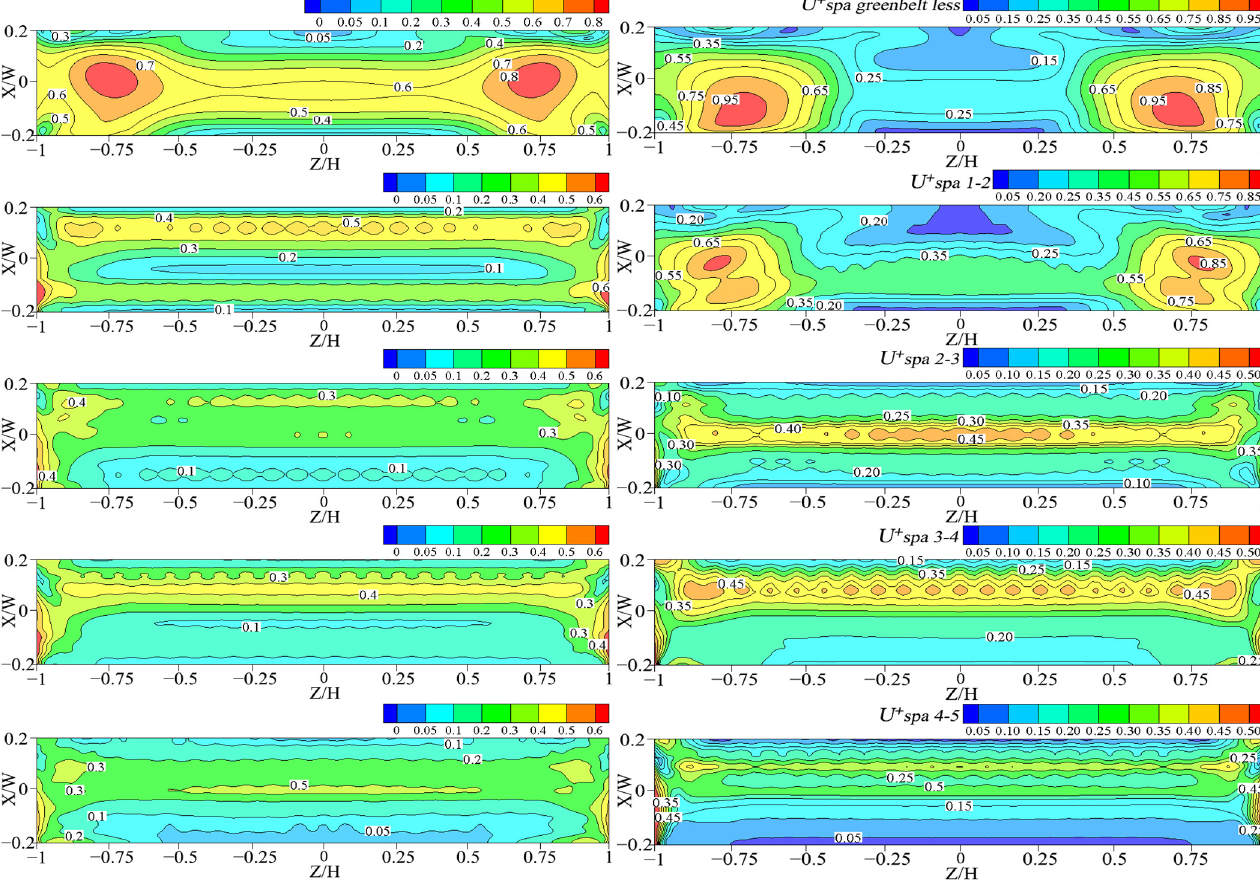
Figure 14. The normalized flow velocity diagram U + at the pedestrian breathing zone, with different road green-belt scenarios in the step-down street, with ASF = 3/1 ( left ) and 3/2 ( right ).